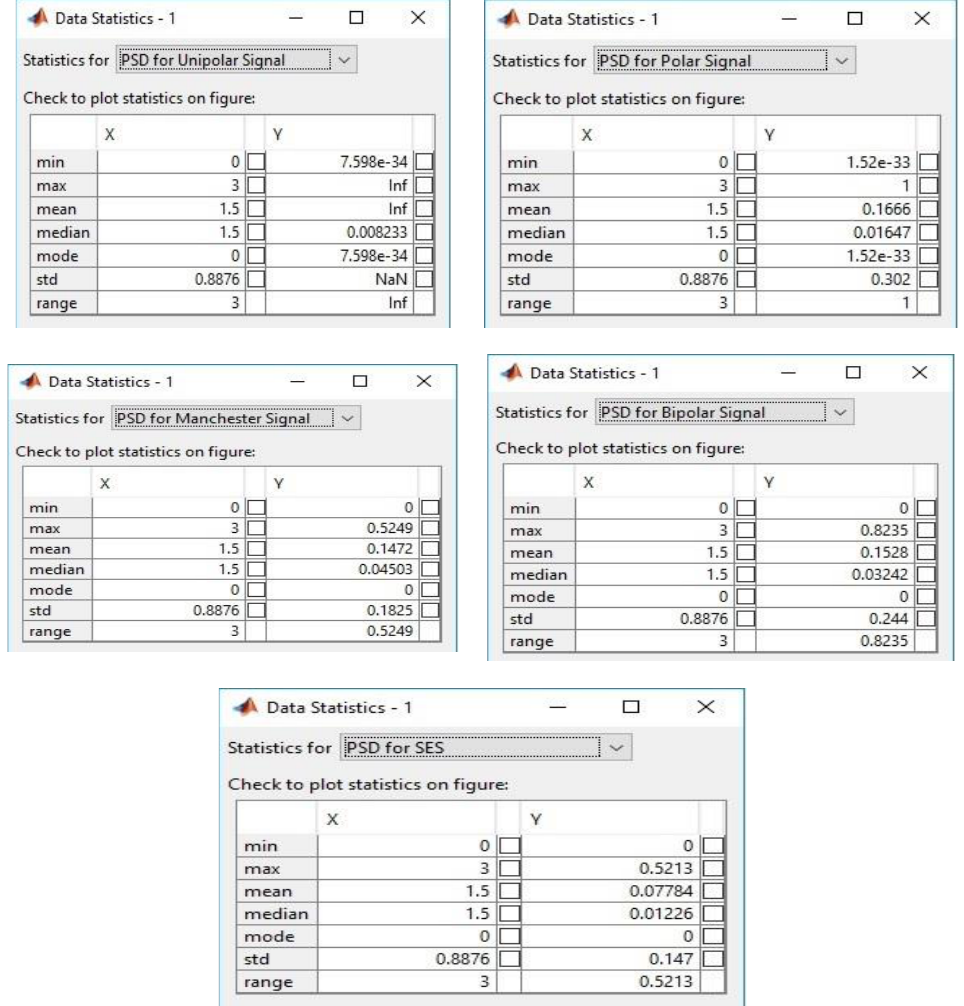
Figure 8. Statistical comparison of SES with other digital encoding schemes.